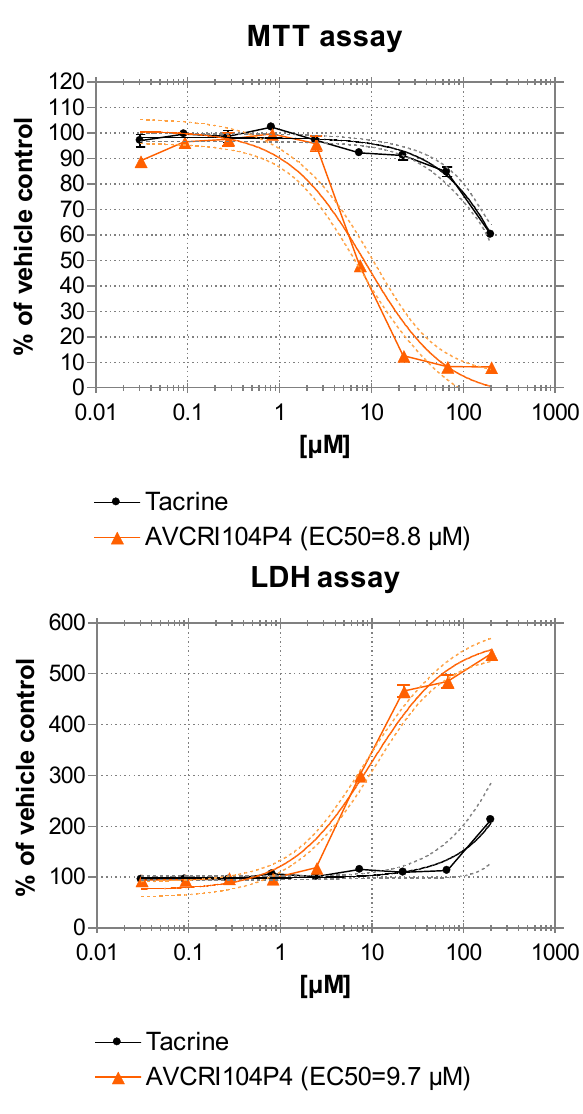
Figure 5. AVCRI104P4 and tacrine dose response in HepG2 cells. HepG2 cells were treated with AVCRI104P4 and tacrine at the indicated concentrations for 24 h.